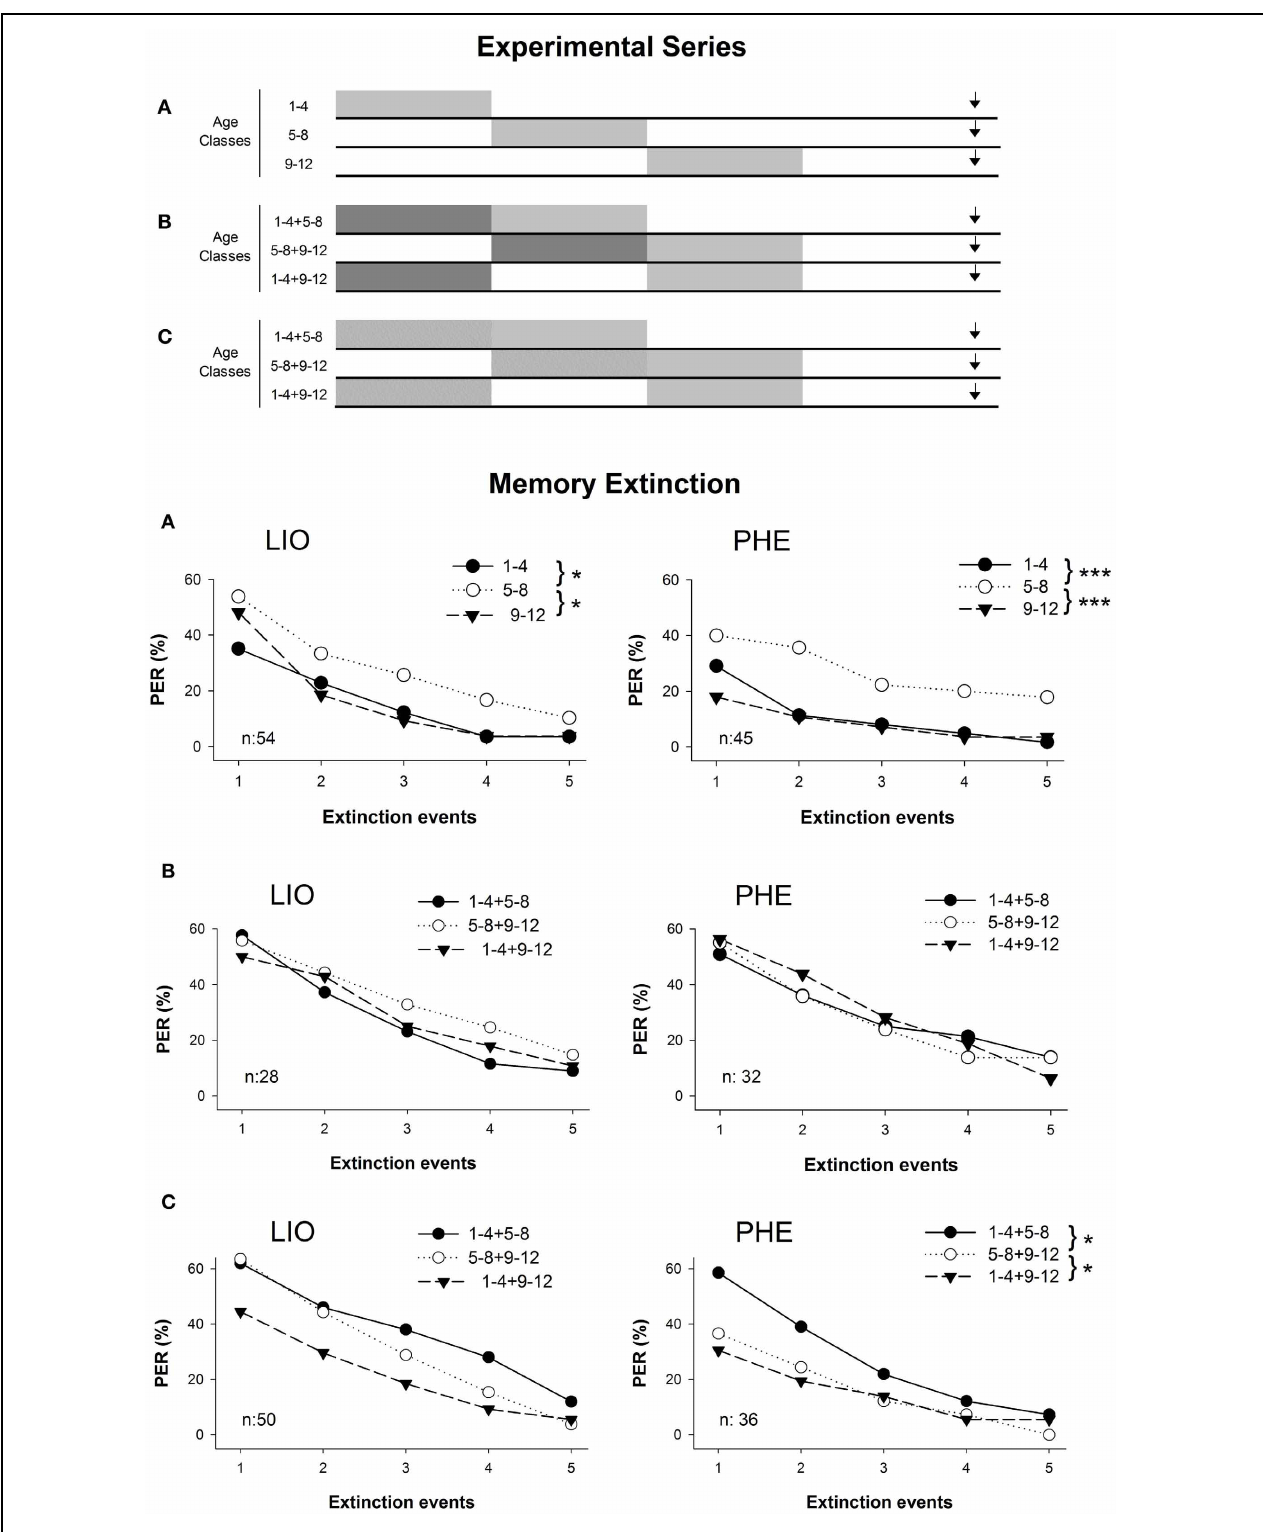
days (gray boxes), and their olfactory memories evaluated at 17 days of age (black arrow). PER to LIO (left panel) or PHE (right panel) were tested when they were offered alone in the sugar solution. (B) In addition to the scented